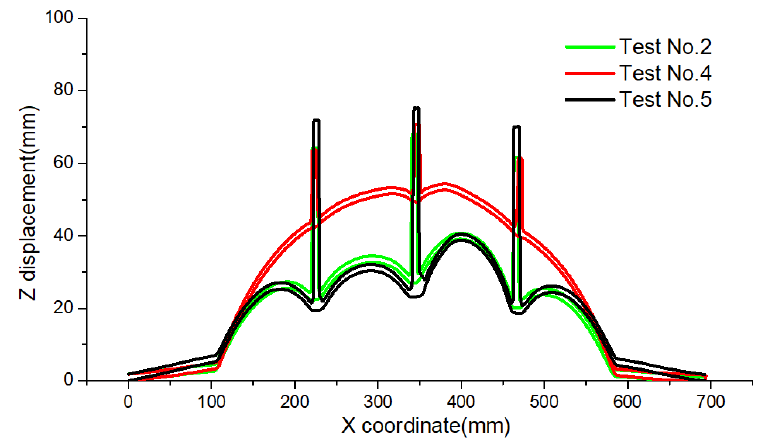
Figure 24. Central H-H section profile of Tests No. 2, 4, and 5.